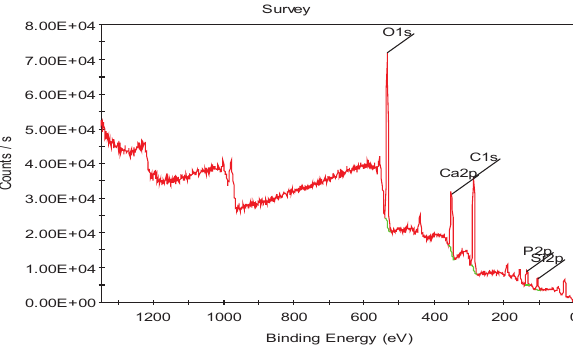
Figure 9: XPS analysis of HA-PETRA microcapsules after release of β-tricalcium